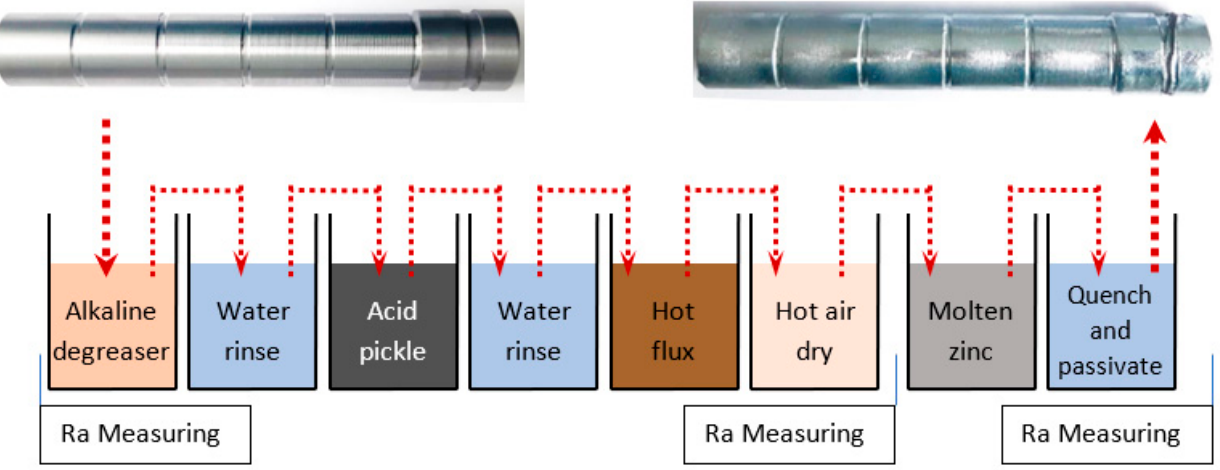
Figure 6. Speci fi c technological fl ow of hot dip galvanizing with priming only.